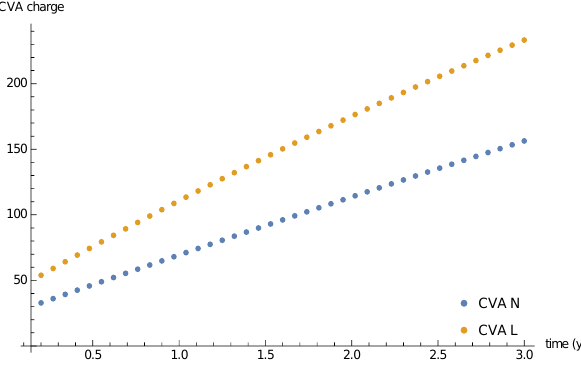
Figure 9. Comparison of CVA N and CVA L for Case